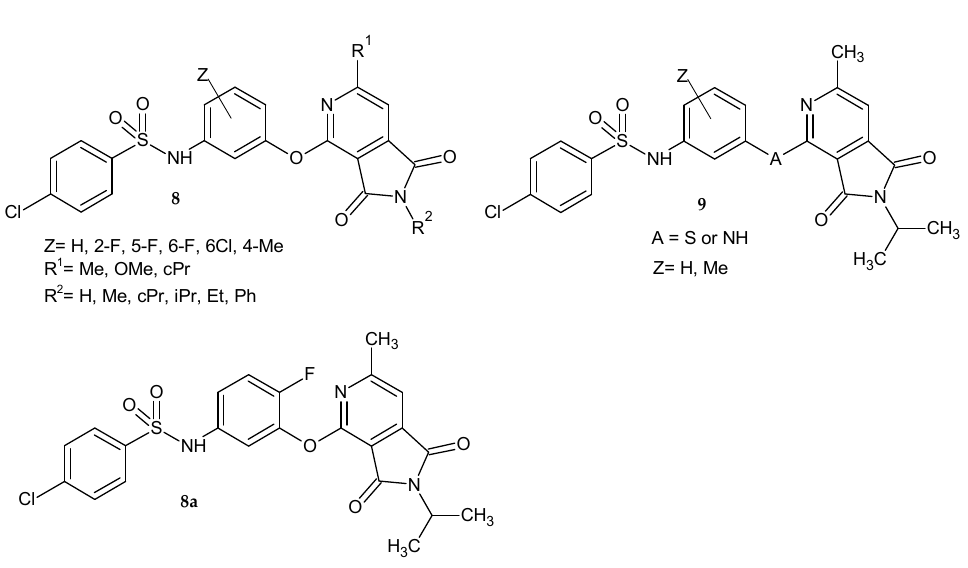
Figure 5. Pyrrolo[3,4- c ]pyridine-1,3-dione derivatives 8 – 9 with 4-chloro-N-phenyl-benzenesulfonamide substituent as GPR119 agonists and the most active compound 8a